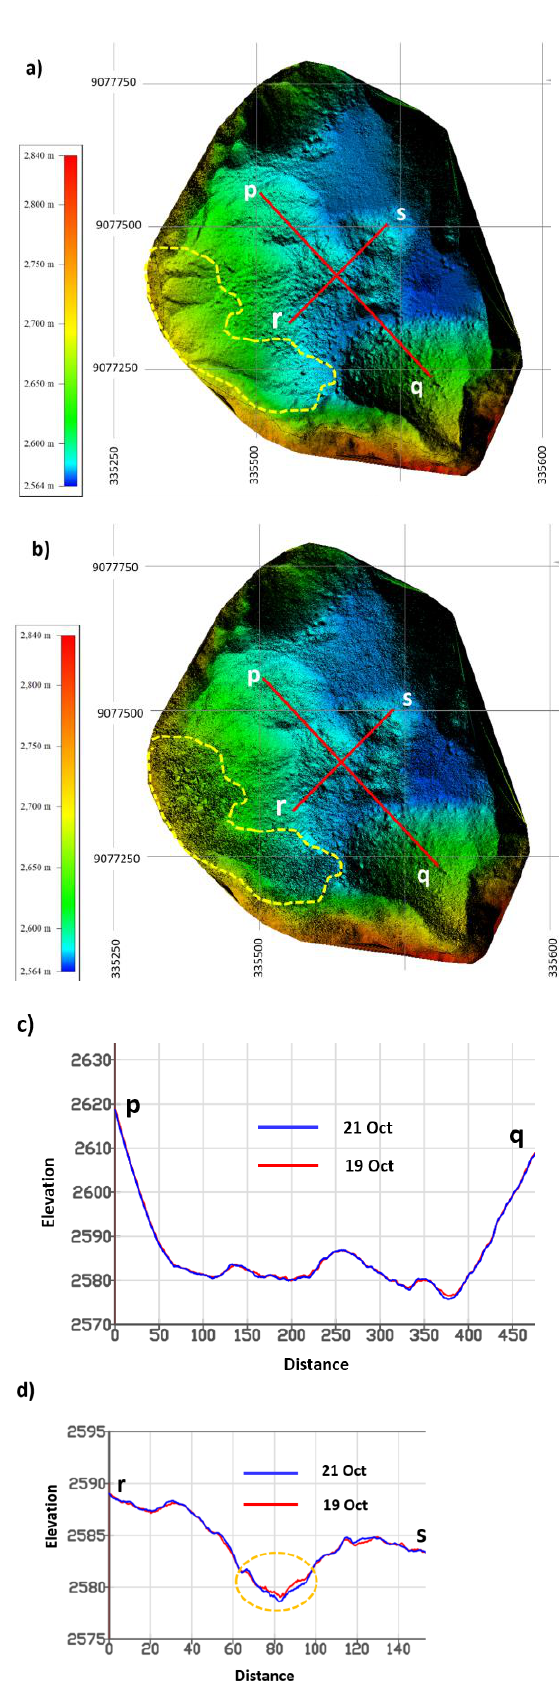
Figure 11. (a) shaded relief of the 21 Oct and (b) 19 Oct Digital Elevation Model. (c) cross-section at NW-SE direction. (d) cross-section at SW-NE direction.